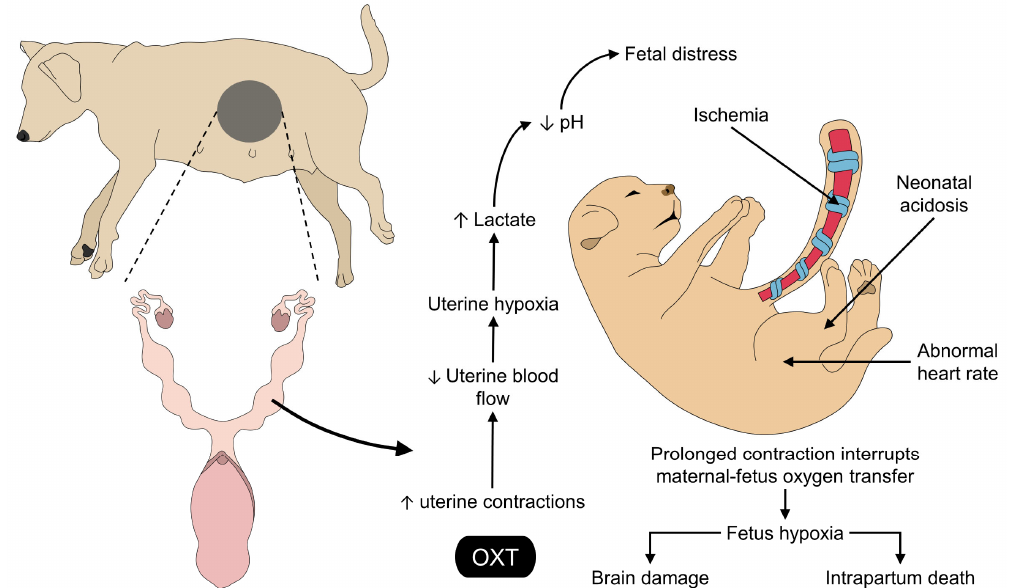
Figure 2. Effect of oxytocin administration on the umbilical cord and fetus health. Although OXT is commonly used during the onset of parturition, adverse effects directly on fetal health have been reported. After the hyperstimulation of the myometrium, prolonged contractions reduce uterine blood flow, resulting in a hypoxia state and accumulation of lactate. These events cause fetal distress with main consequences such as neonatal hypoxia, acidosis, abnormal heart rate, umbilical cord ischemia, and possible brain damage or intrapartum death when administering OXT. OXT: oxyto ‐ cin.